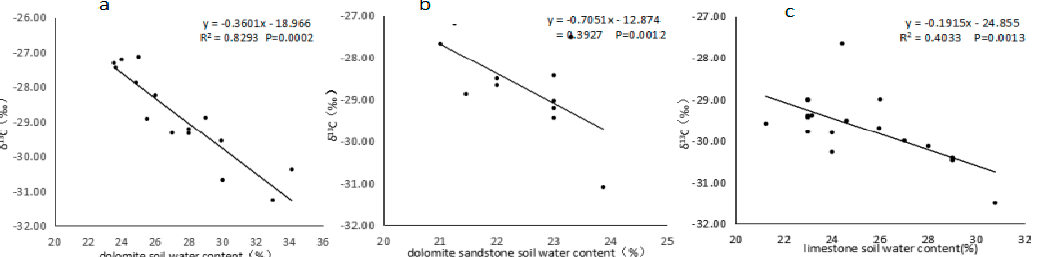
Figure 2. Relationship between the δ 13 C value of the dominant species and the soil water content in di ff erent lithological soil types. ( a ) dolomite, ( b ) dolomite sandstone, ( c ) limestone.